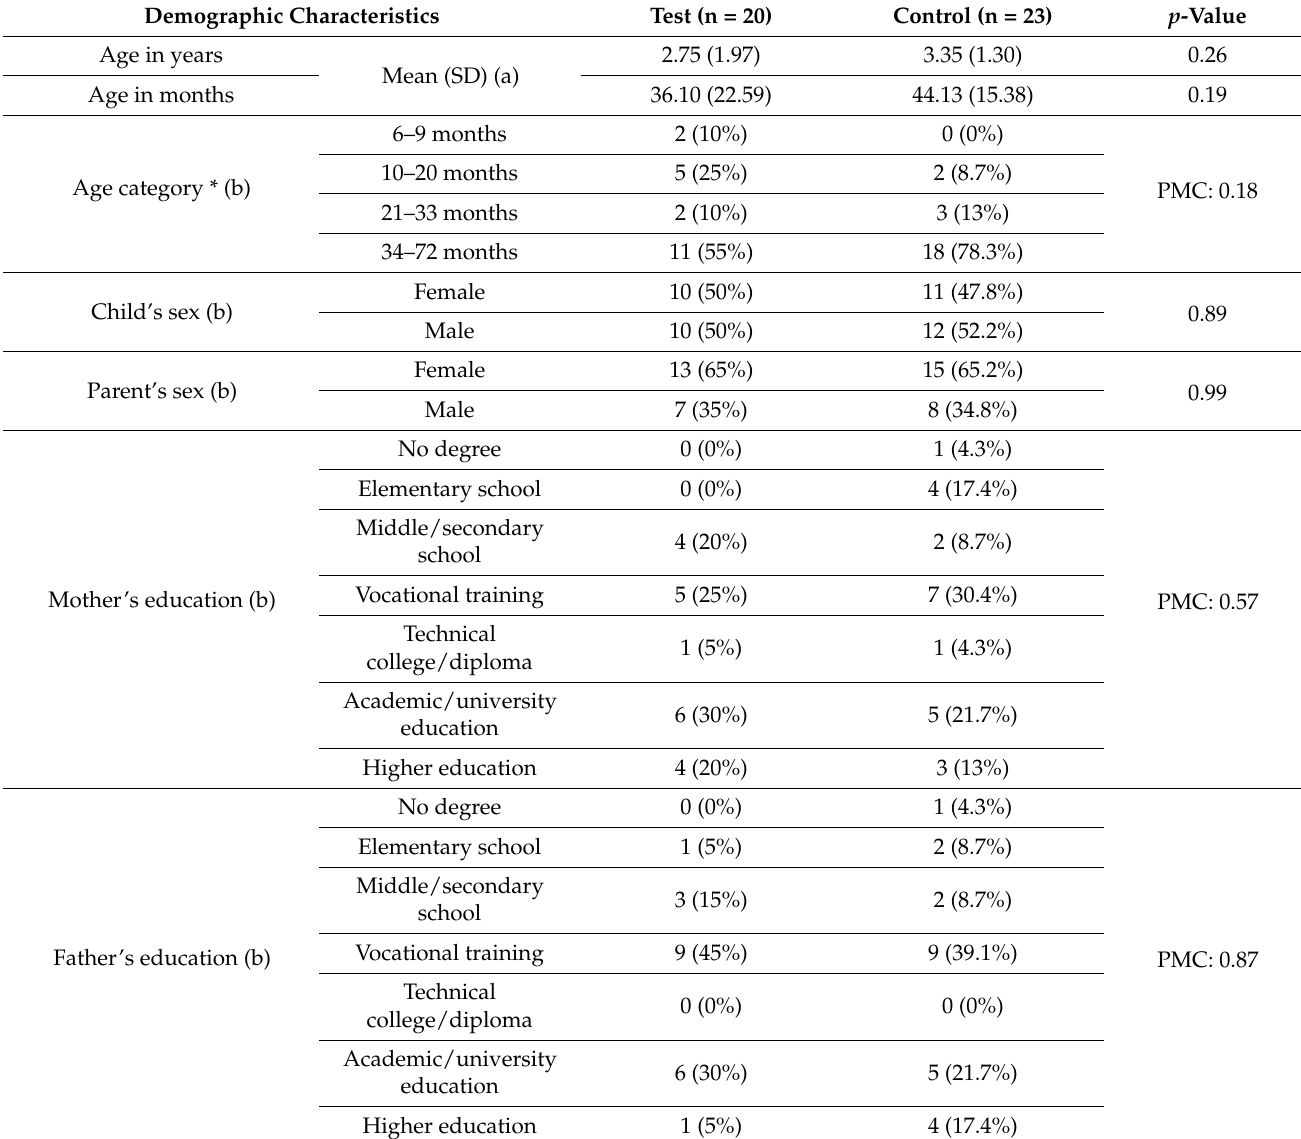
Table 2. Demographic profile of participants in the randomized clinical trial (Part